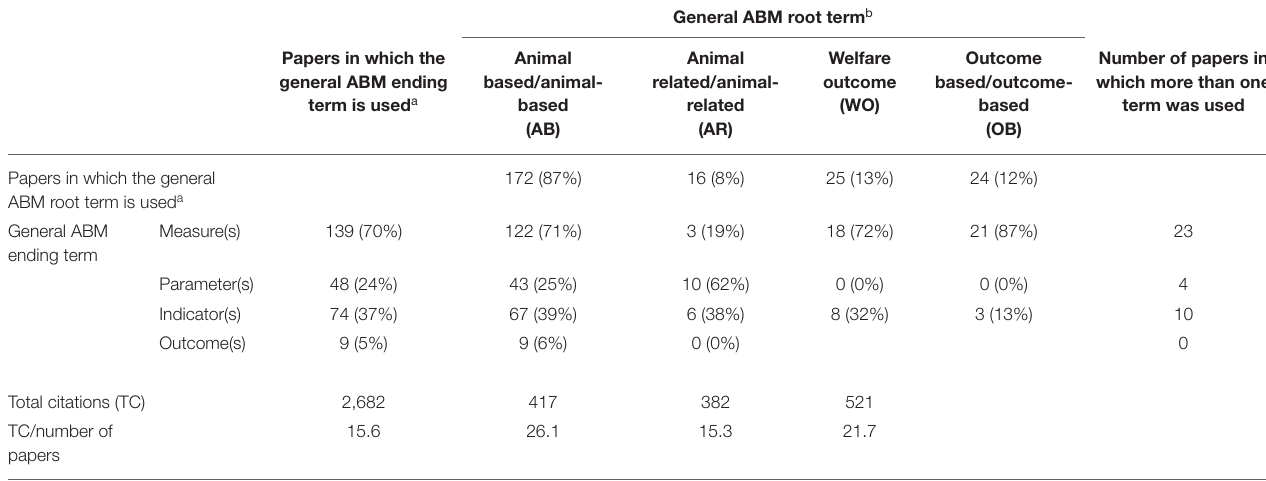
TABLE 4 | Number of documents and percentage (in brackets), total citations, and average number of citations per paper according to the general animal-based measures (ABM) root, ending and codified terms.